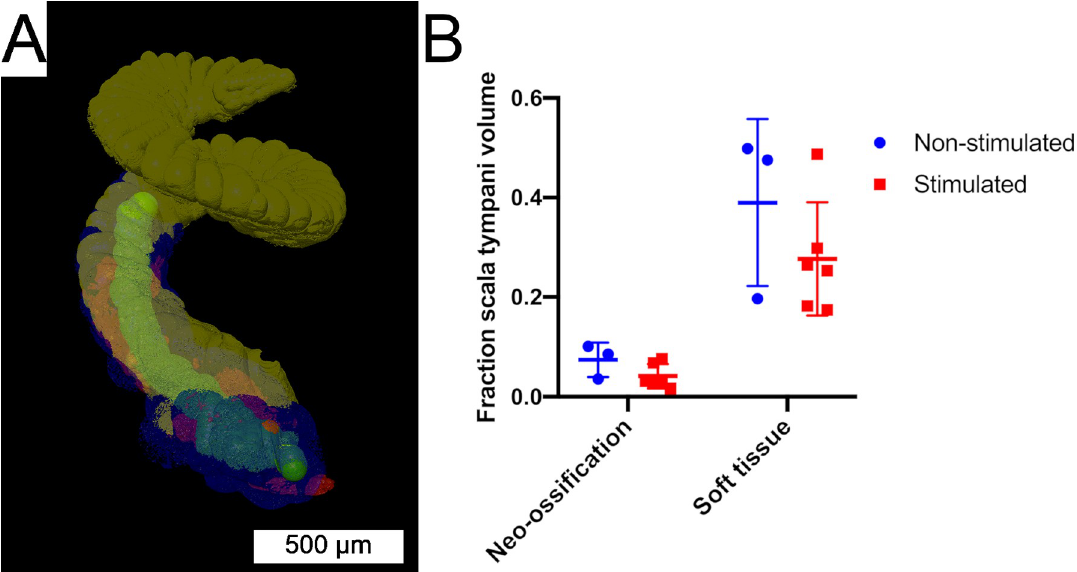
Fig 10. Volumetric cochlea segmentation. (A) 3D rendering of a volume segmented 3D x-ray microscopy cochlea image stack. Regions of interest include the implant tract (green), soft tissue response (blue), neo-ossification (red) and unoccupied scala tympani (yellow). (B) The fractional volume of the scala tympani occupied by neo-ossification or soft tissue response was quantified. Individual data for non-stimulated (blue dots) and stimulated (red squares) subjects are include with horizontal bars showing group mean values. There were no significant differences between groups (p > 0.5). Error bars provide